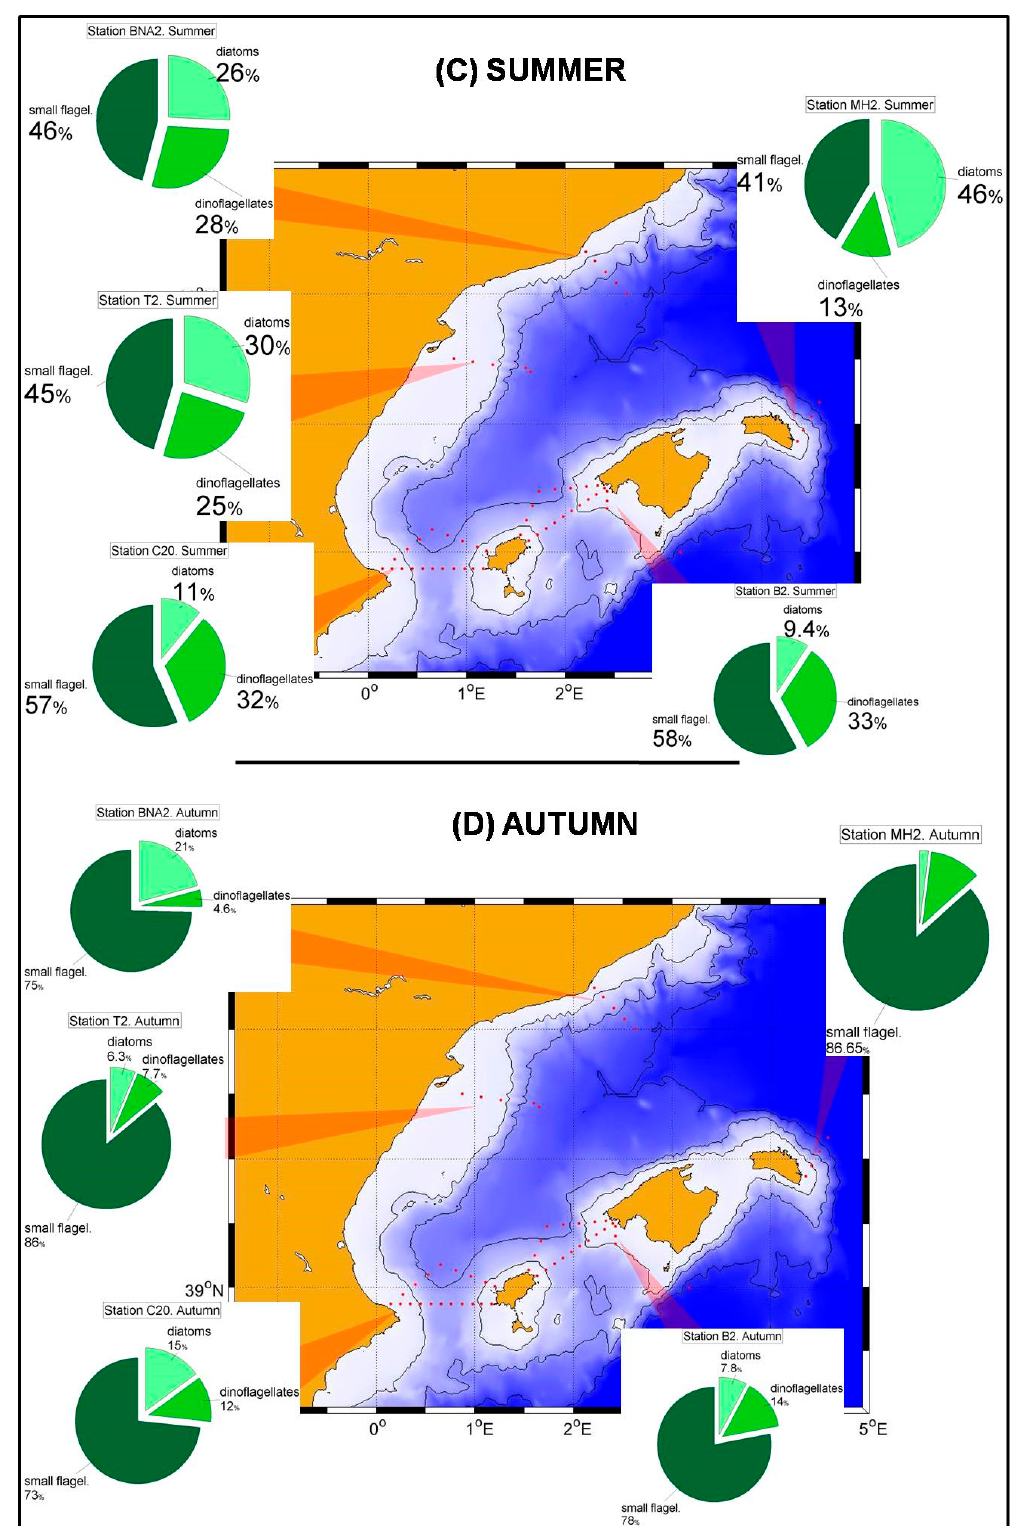
Figure 7. Relative abundances expressed as percentages for the transects to the north of Cape Palos for diatoms (light green), small flagellates (dark green) and dinoflagellates (intermediate green) integrated from the sea surface to 100 m. ( A – D ) correspond to winter, spring, summer and autumn respectively.